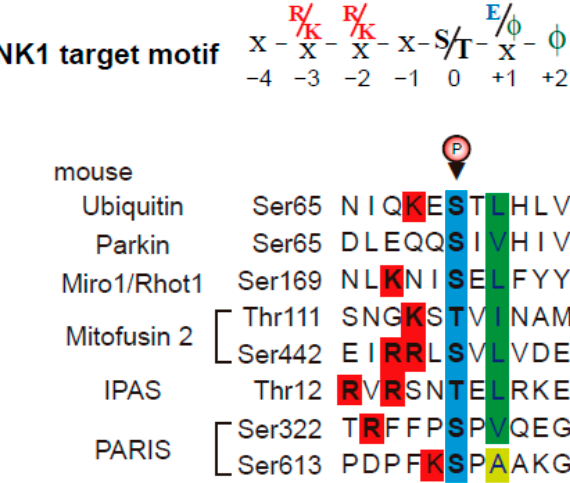
Figure 2. Alignment of amino acid sequences containing the phosphorylation sites of several PINK1 substrates. The known Ser or Thr residues phosphorylated by PINK1 (blue box) are indicated by an arrowhead with phosphorylation (P). Protein sequences of Mus musculus are presented. Hydrophobic amino acids (green box) and alanine (yellow box) found two residues ( + 2) after phosphorylation sites are shown. Hydrophobic amino acids or acidic amino acids at position + 1 after the phosphorylation site are preferred. Basic amino acids found before the phosphorylation sites are shown (red box). Phosphorylation sites of drosophila MIC60 / Mitofilin are not included because phosphorylation sites of mouse MIC60 / Mitofilin corresponding to drosophila MIC60 / Mitofilin cannot be identified using homology searches. From these observations, an optimal PINK1 target motif is given at the top using one-letter codes ( ф : hydrophobic amino